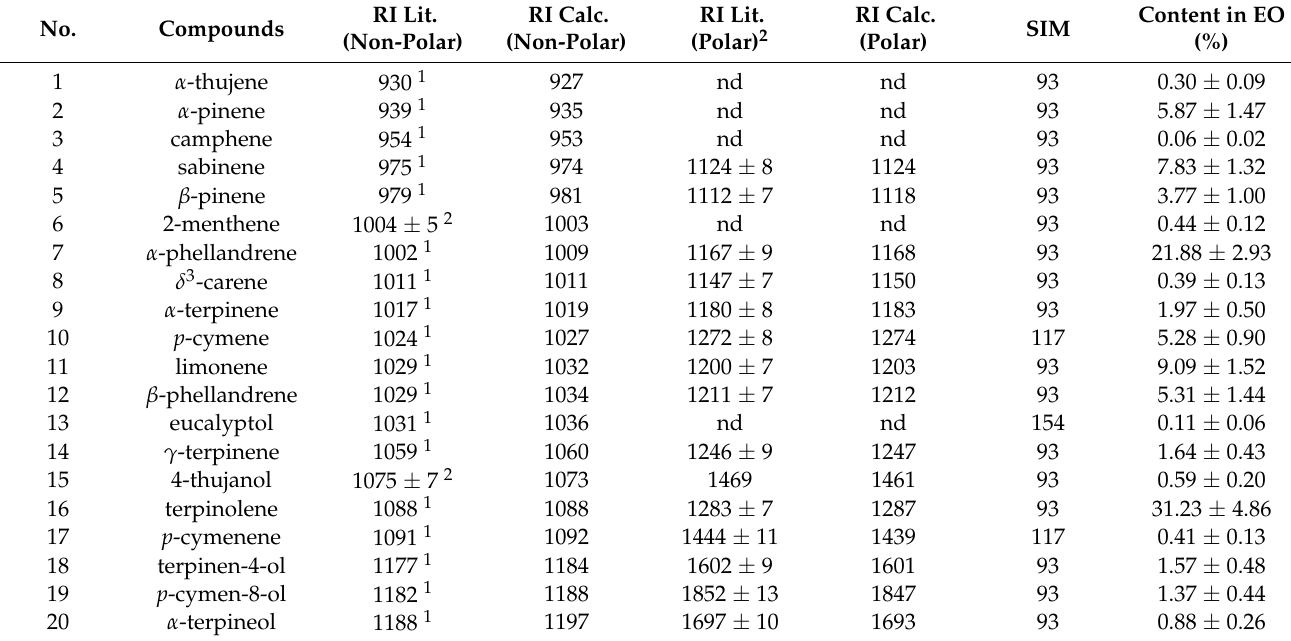
Table 1. Chemical composition of an EO obtained from the oleoresin of C. schweinfurthii collected in Gabon (Ntoum region, tree #1).